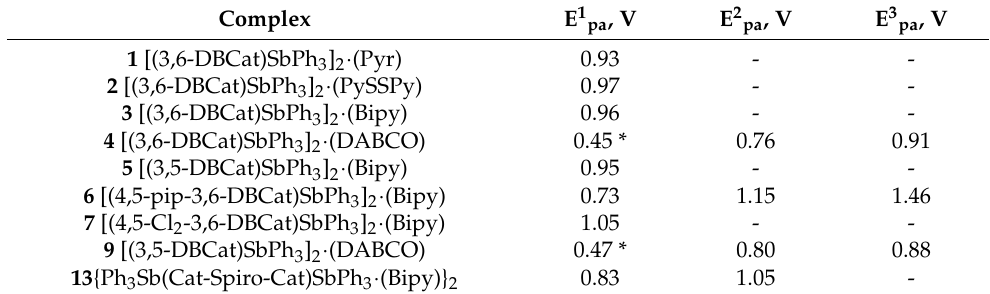
Table 2. The electrochemical potentials for 1 – 7 , 9 , and 13 in the accordance with CV (GC, СH 2 Cl 2 ,